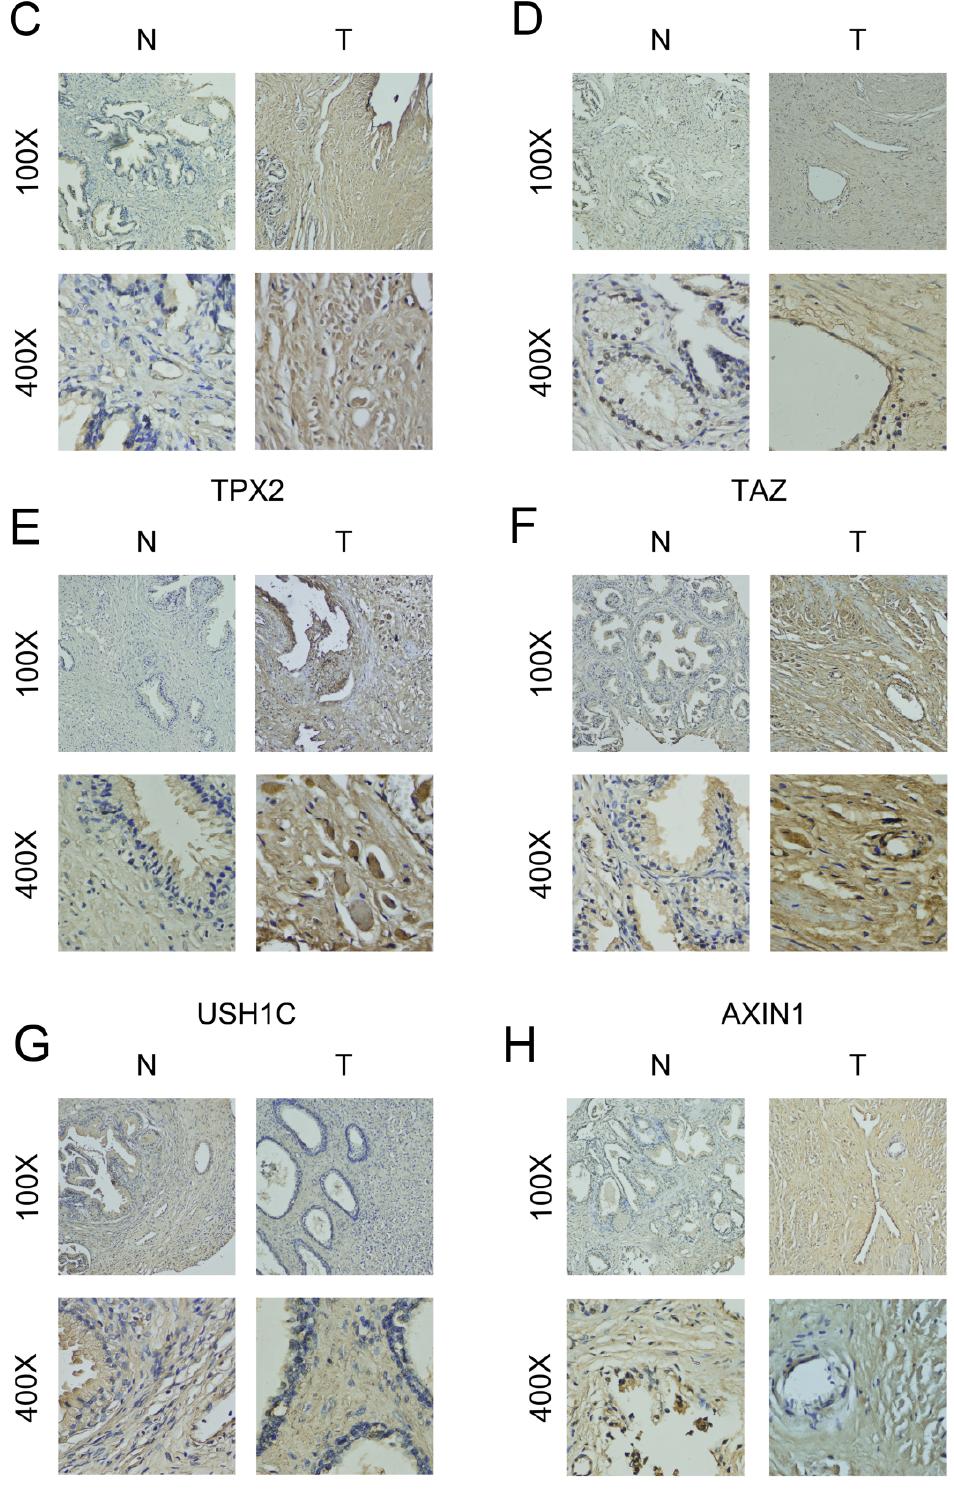
Figure 7. The mRNA expression levels between PCa cells and normal prostatic epithelial cells of FUS, CBX2, TPX2, TAZ, USH1C and AXIN1 ( A ). The protein expression level between BPH and PCa tissue of FUS, CBX2, TPX2, TAZ, USH1C and AXIN1 ( B – H ). *: p < 0.05; **: p < 0.01; ***: p < 0.001; ns: not significant.